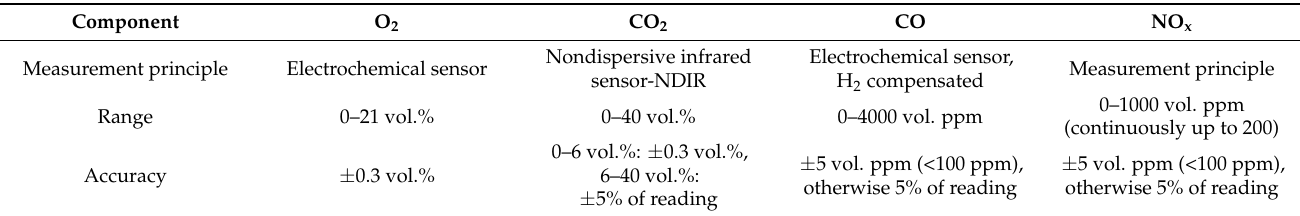
Table 1. Specification of the Wöhler A 550 analyser [40].